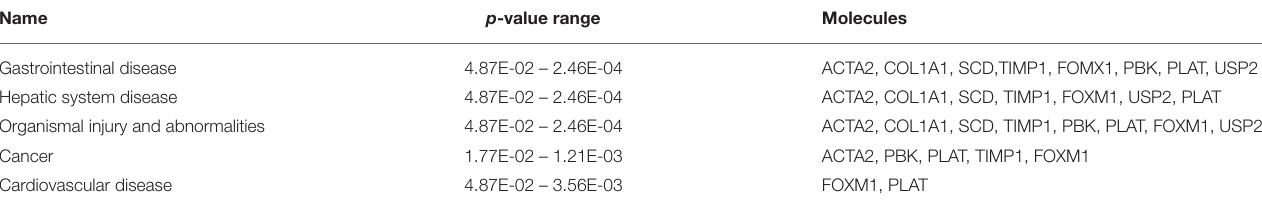
TABLE 6 | Top diseases and biofunctions between Phb1 + / − and WT.